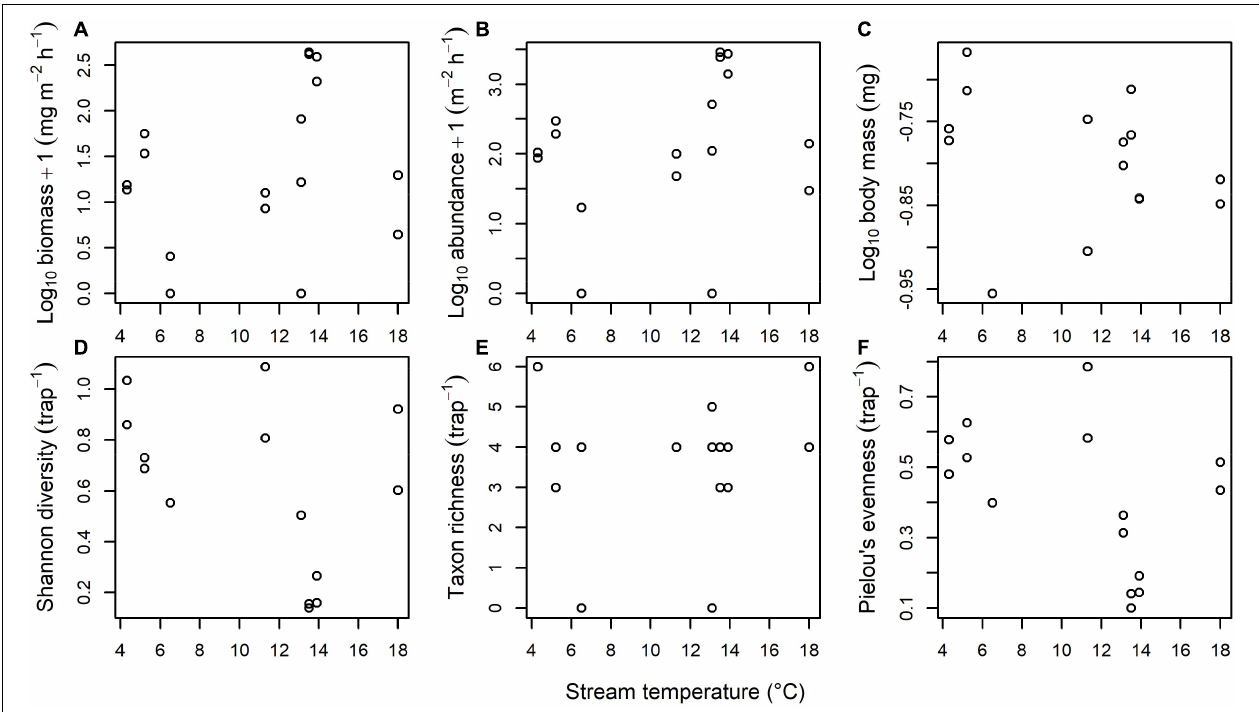
FIGURE 3 | Effect of stream temperature on the freshwater subsidy of aquatic larvae emerging as adult flies into the terrestrial landscape. There was no significant effect of temperature on the (A) Biomass, (B) Abundance, (C) Body mass, (D) Shannon diversity, (E) Taxon richness, or (F) Pielou’s evenness of emerging